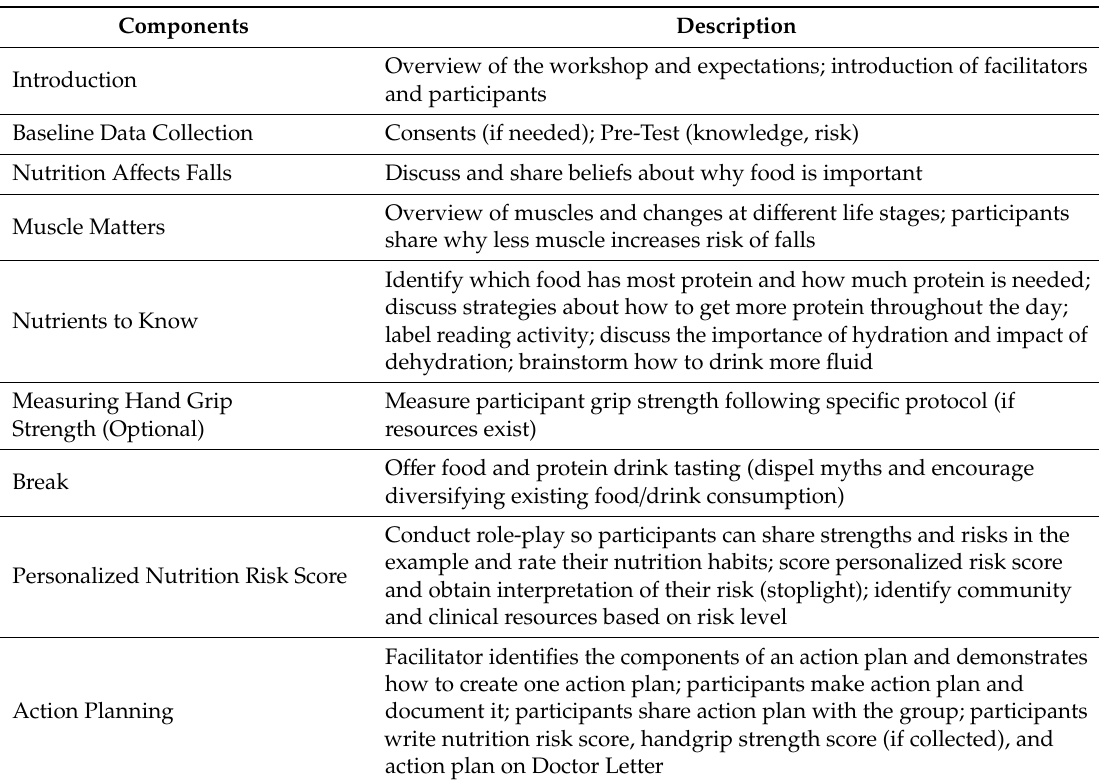
Table 1. Stepping Up Your Nutrition (SUYN) Brief Intervention